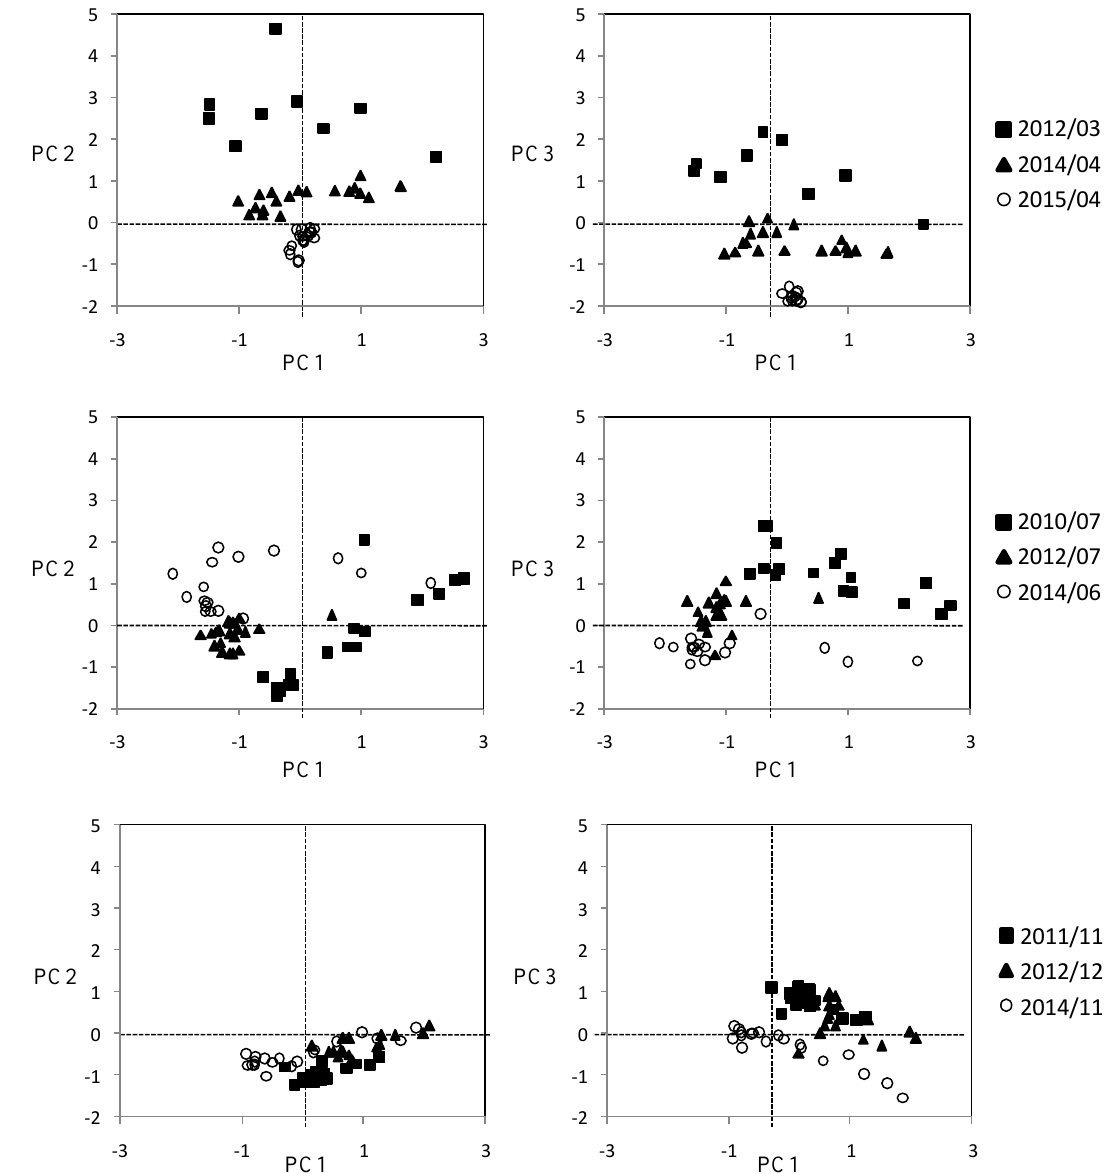
Figure 8. Bi-plot for the scores obtained for each sample for the three first principal components (PCs) extracted from the PCA (relation between PC1 and PC2, left panel,—and between PC1 and PC3, right panel). Data are grouped according to three seasonal periods: spring (top), summer (middle), and autumn (bottom).